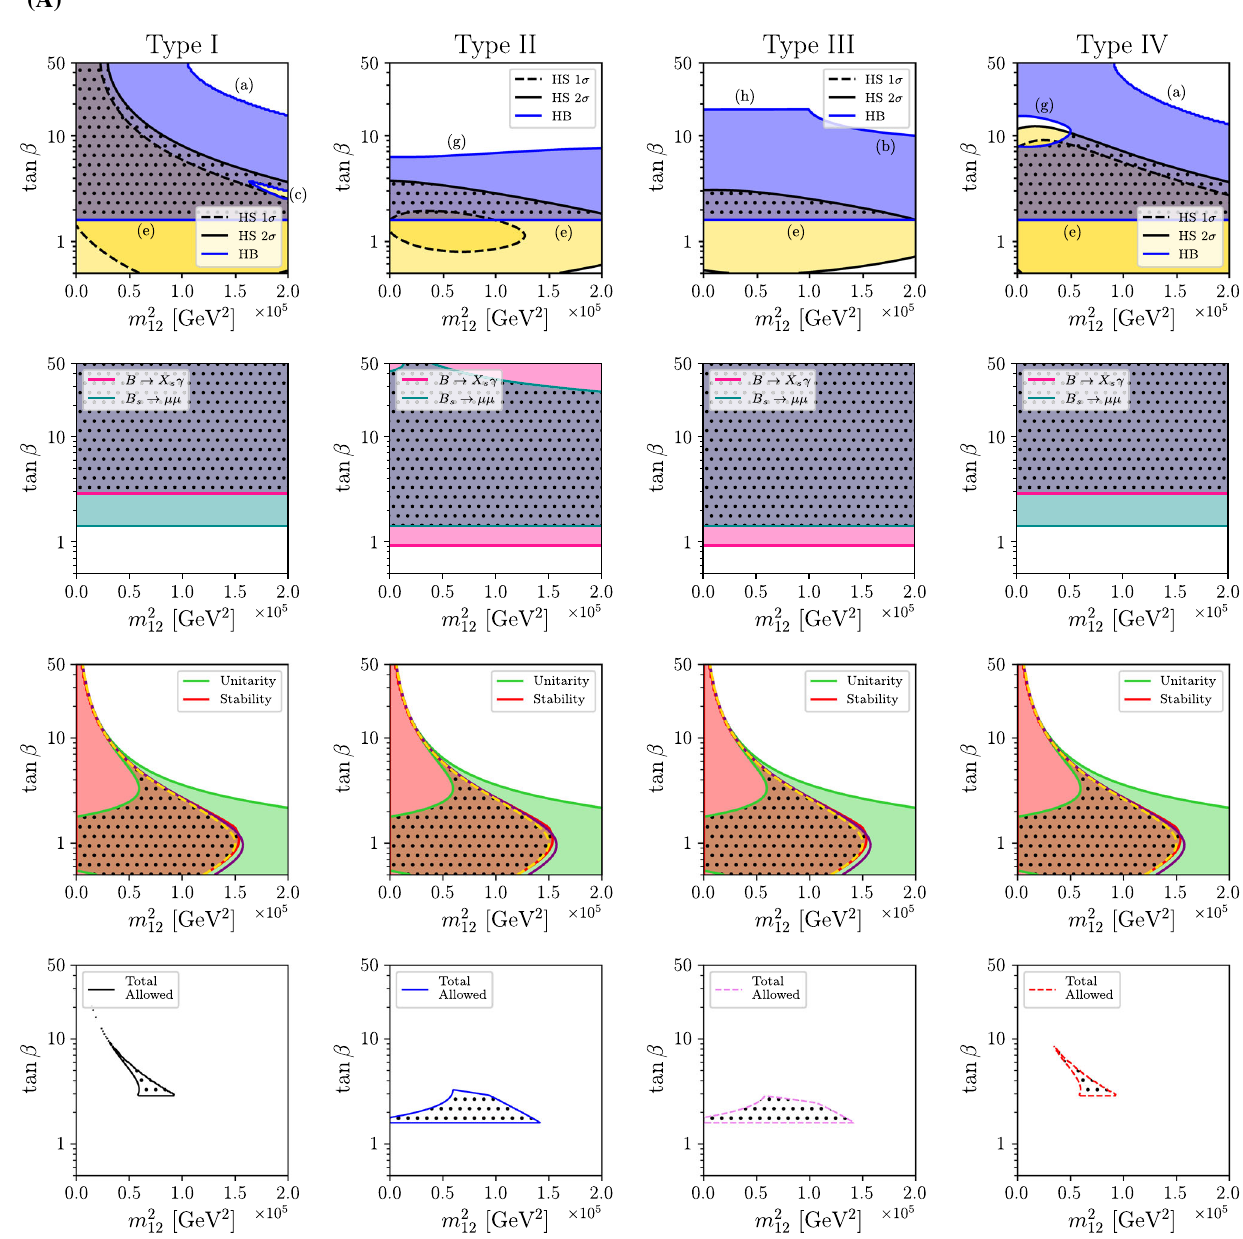
Fig. 2 A Allowed regions from the restrictions on the parameter space in benchmark scenario 2 in the m 2 –tan β plane with m = 550 GeV 12 and c β − α = 0 . 02. The results for type I, II, III and IV in the left, sec- ond, third and right column, respectively. The upper, second and third row show the restrictions from HiggsBounds / HiggsSignals , the flavor observables and from unitarity/stability, respectively. The fourth row indicates the regions allowed by all constraints in the respective